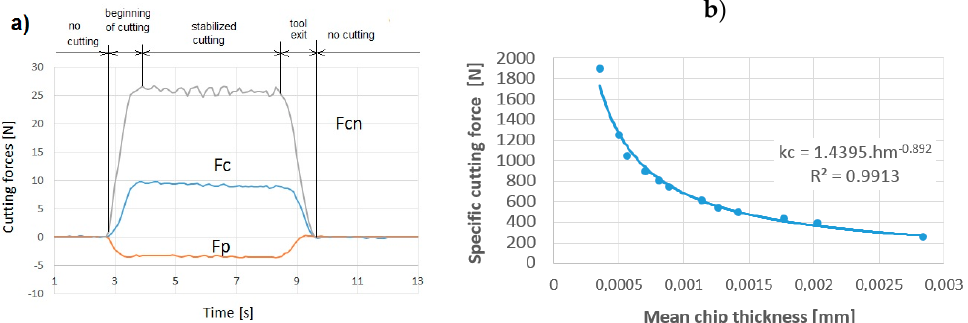
Figure 10. A typical time series of cutting forces when milling UHMWPE. ( a ) Fc-cutting force, Fcn-perpendicular cutting force, Fp-passive force, ( b ) specific cutting force as a function of chip thickness.